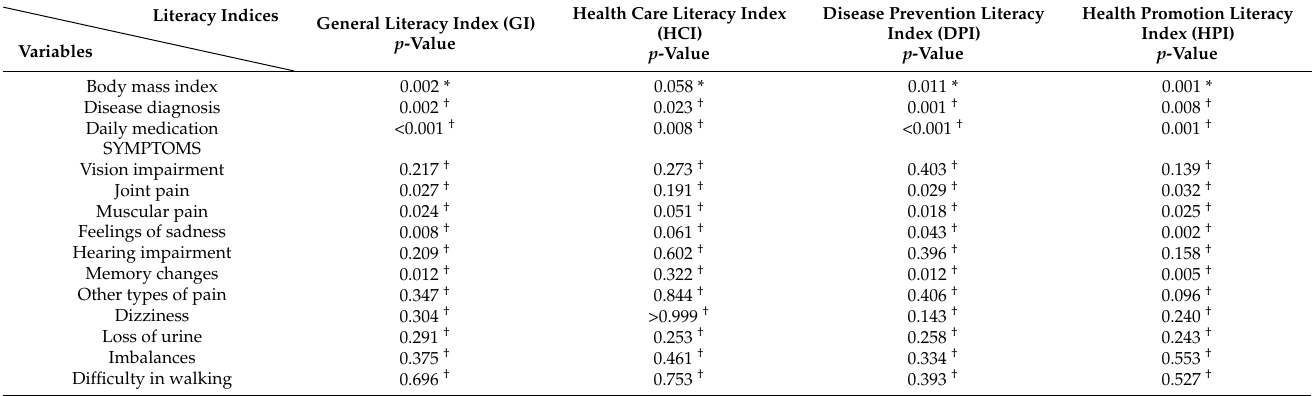
Table 4. Association between clinical variables and health literacy indices.